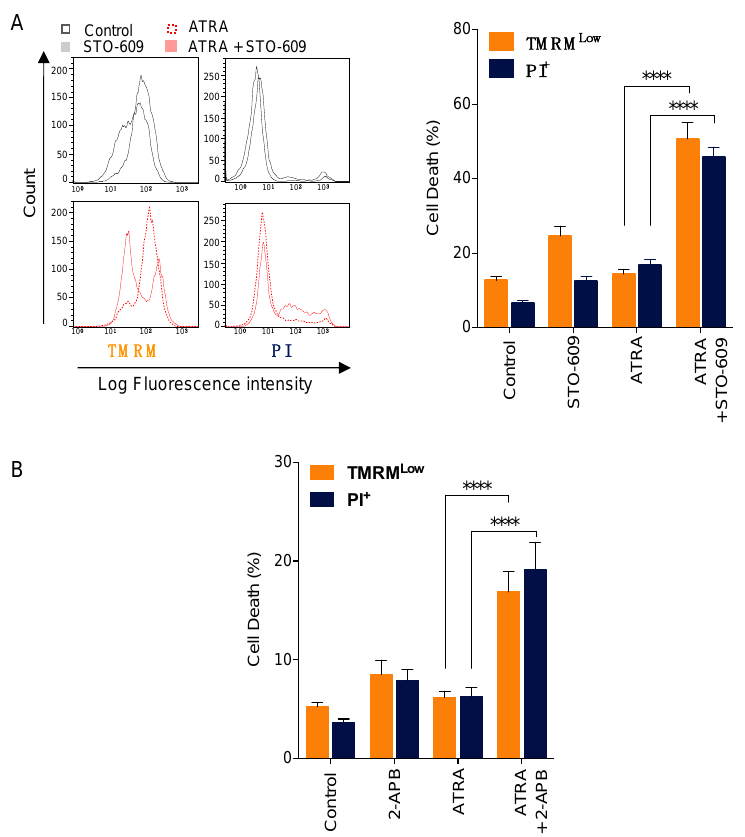
Figure 6. Pharmacological inhibition of SOC channels and CAMKK2 promotes ATRA-induced cell death. NB4 cells were pre-treated with STO609 (5 μg/mL) and then treated with 1 μM ATRA for 5 days. Cell death was assessed by the measurement of (i) the mitochondrial transmembrane potential using TMRM dye and (ii) the plasma membrane permeability using propidium iodide (PI) staining. ( A ) Left panel, representative flow cytometry histograms for TMRM and PI cell staining. Right panel, percentage of cells exhibiting low TMRM staining and high PI staining were scored for each condition. ( B ) NB4 cells were pre-treated with 2-APB (44 μM) prior to treatment with 1 μM ATRA for 2 days. At the end of this treatment, cell death was scored as described in ( A , B ) Results are means ± SD of three and four independent experiments realized in triplicate for STO-609 and 2-APB, respectively. **** p -value <